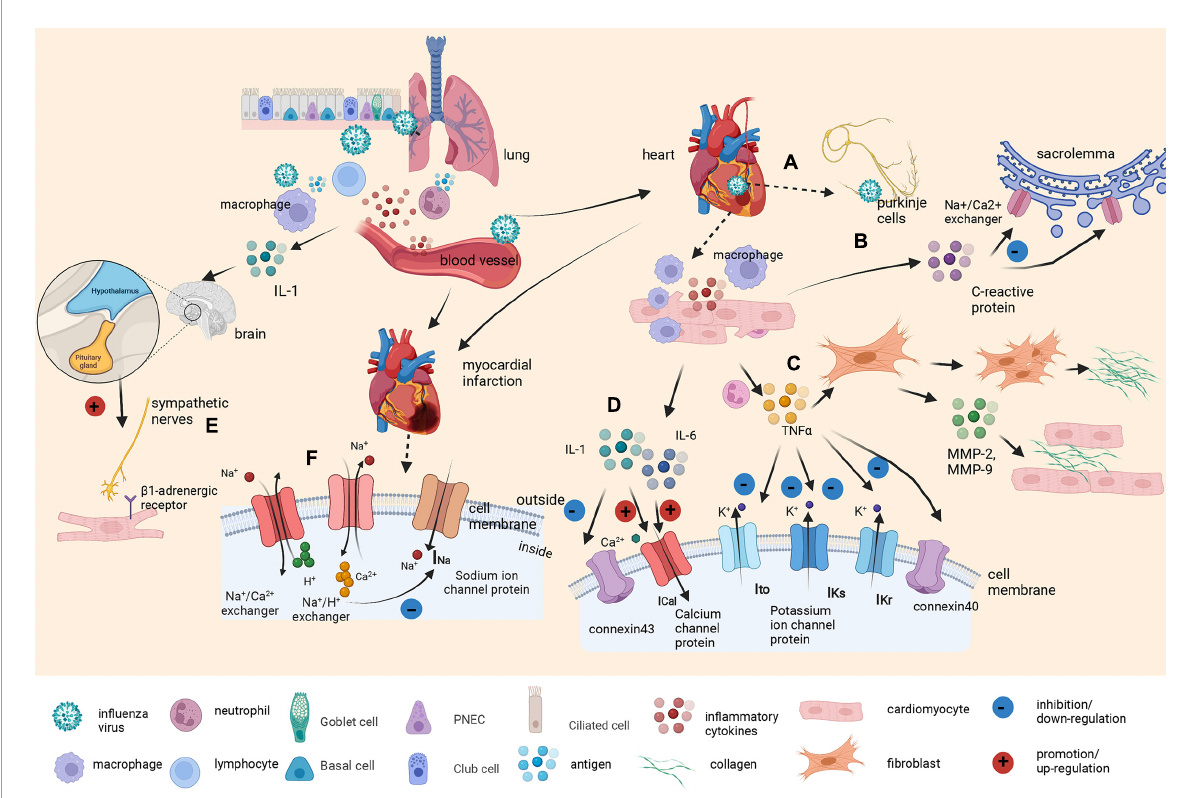
FIGURE4 Graphical abstract on the underlying molecular mechanism of the influenza virus as a trigger of arrhythmia. Influenza viruses enter the body through the respiratory tract. The innate immune response induces various cytokines and chemokines to recruit macrophages and neutrophils to control the virus. Inflammatory cytokines also increase vascular permeability, which helps the virus enter the bloodstream. (A) Once the virus reaches the heart, it can replicate in cardiomyocytes and Purkinje cells, directly affecting the cardiac conduction system. (B) At the same time, elevated C-reactive protein levels leads to membrane dysfunction by inhibiting the exchange of sodium and calcium ions in sacrolemmal vesicles. (C) Tumor necrosis factor α (TNF α ) produced by macrophages surrounding cardiomyocytes promotes fibroblast activation and collagen III deposition. It also induces proliferation, the secretion of matrix metalloproteinase-2 (MMP-2) and matrix metalloproteinase-9 (MMP-9), and the invasion of myocardial fibroblasts. Additionally, it reduces the expression of connexin40, results in a strong decrease in the transient outward current (Ito) and downregulates the rapid and slow component of the delayed rectifier potassium current (IKr and IKs). (D) Other cytokines, such as interleukin-6 (IL-6) and interleukin-1 β (IL-1 β ), prolong APD by enhancing the L-type calcium current (ICaL). IL-1